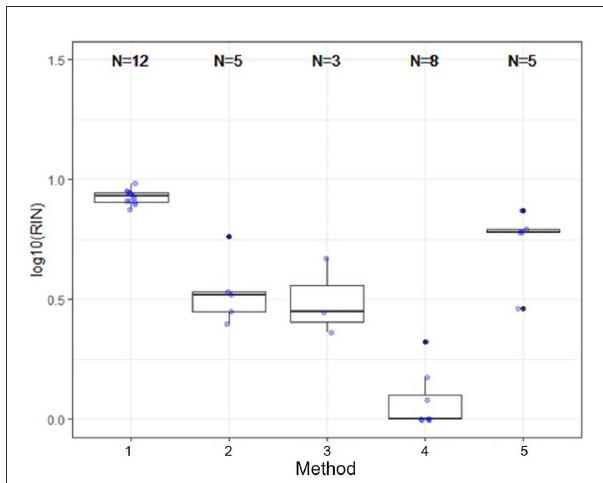
FIGURE2 Extraction method significantly effects RNA integrity. RNA integrity was significantly different for all comparisons except between methods 2, 3, and 5. Therefore, extraction method may significantly impact the outcome of RNA